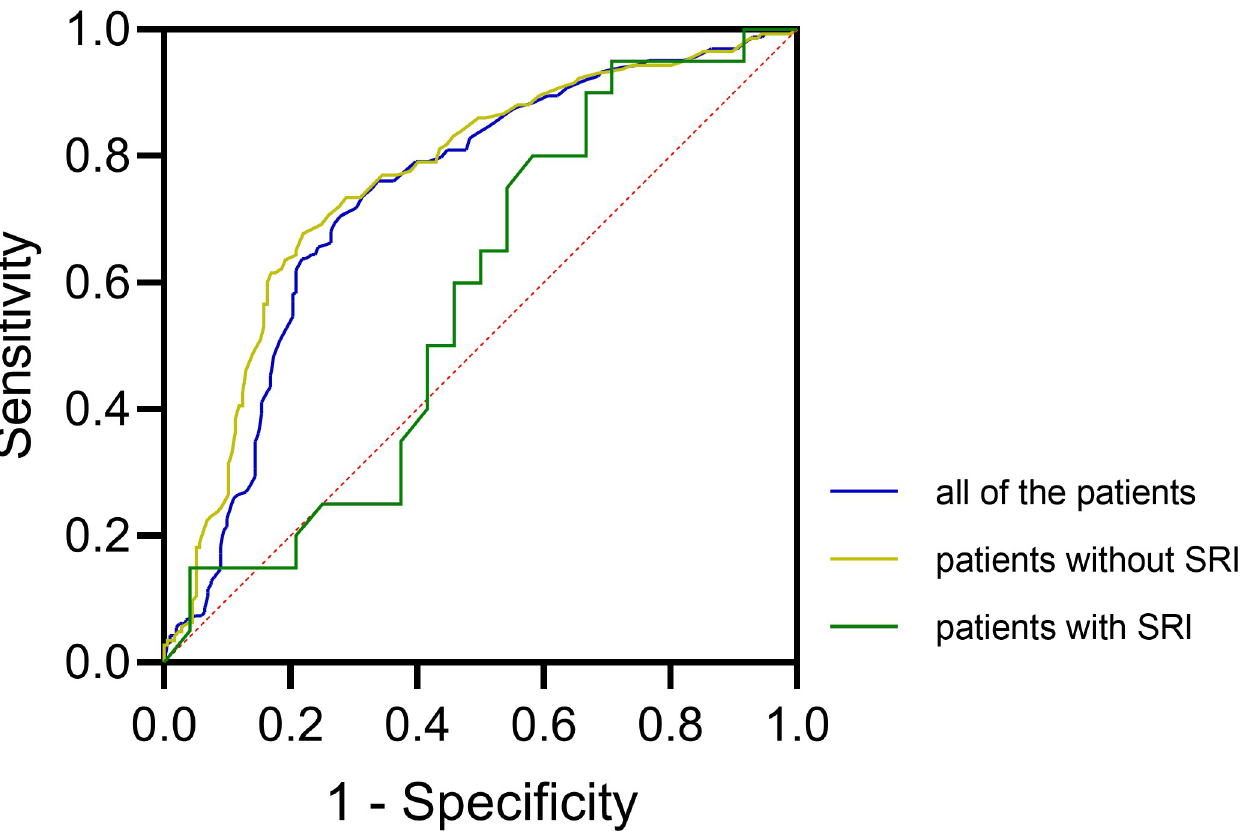
Fig 3. ROC analysis for all of the patients and the two subgroups. The graph illustrates ROC analysis results for all of the patients (blue solid line), patients without SRI (yellow solid line), and patients with SRI (green solid line). It can be seen that all of the patients and patients without SRI share similar curves, but the curve of patients with SRI is far away from them and close to the expected line representing the performance of random guess (diagonal red dashed line). Moreover, the AUC of patients with SRI is distinctly smaller than the other two groups (patients with SRI, 0.57; patients without SRI, 0.76; all of the patients, 0.74). These indicate ESR has a limited value on predicting DFO in patients with SRI. AUC, area under the curve; DFO, diabetic foot osteomyelitis; ESR, erythrocyte sedimentation rate; ROC, receiver operating characteristic; SRI, severe renal